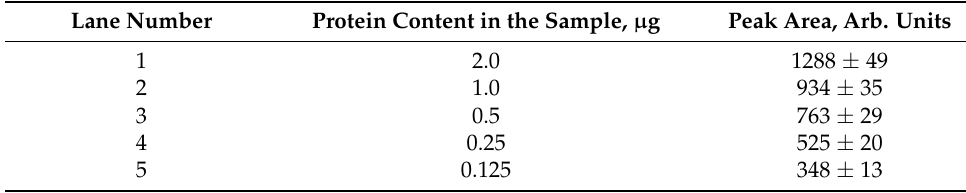
Table 1. The resulting data for plotting the calibration